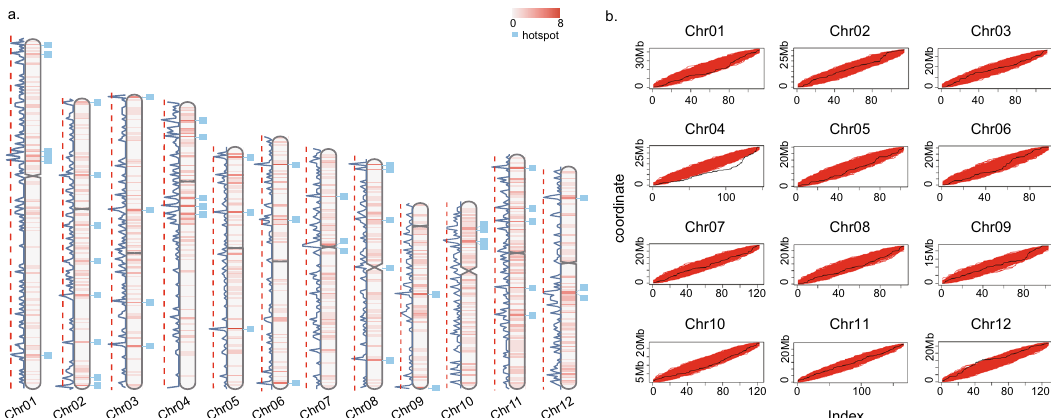
Fig. 2 | Genome-wide inversion distribution. a Chromosome distribution of the pan-genome inversion index, and inversion hotspots. Chromosome heatmaps in the middle along the chromosome represent the density ofinversions. The line on the left of each chromosome represents the number of inversions per 200Kb window. The red dotted line cut off is the top 2% number of inversions in per